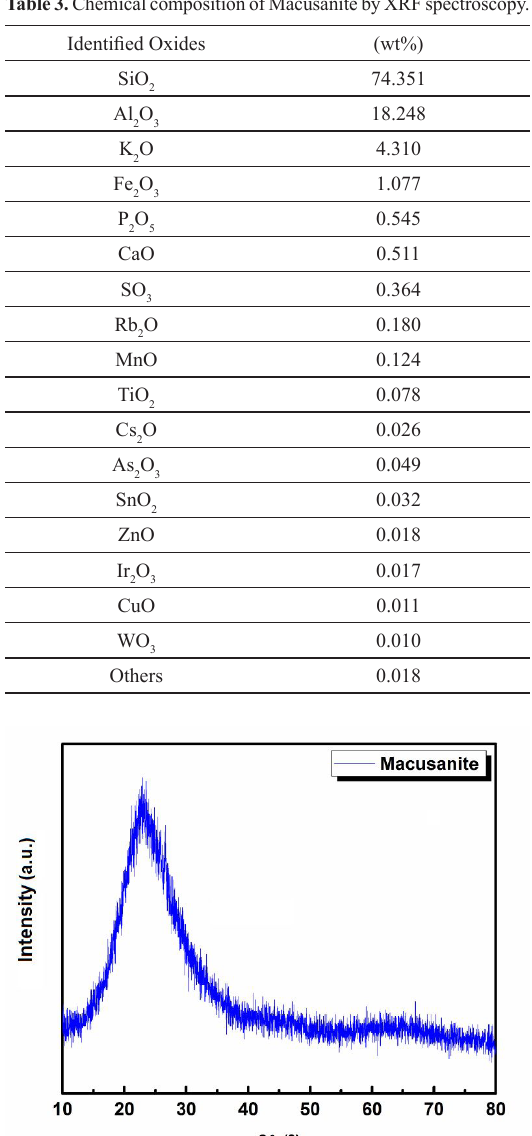
Table 3. Chemical composition of Macusanite by XRF spectroscopy.